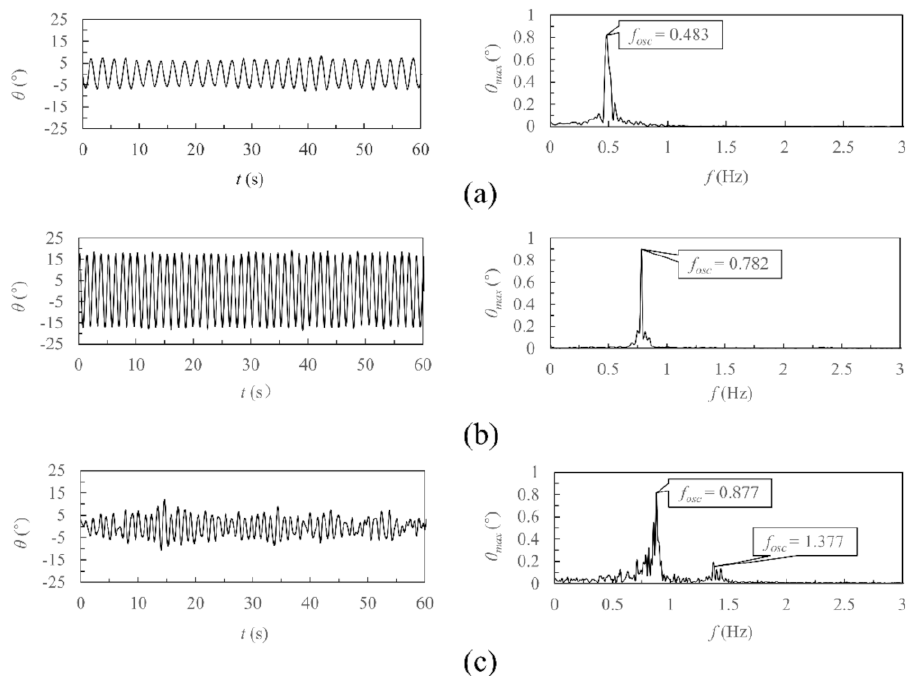
Figure 17. Rotational oscillation time history and spectral characteristics at three typical velocities when L / D = 6.0: ( a ) U = 0.302 m/s ( U r = 3.164); ( b ) U = 0.556 m/s ( U r = 5.83); ( c ) U = 0.810 m/s ( U r = 8.496).